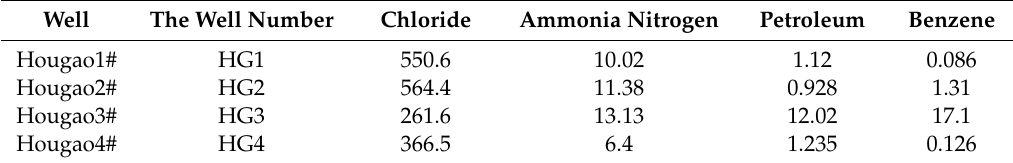
Table 2. Water quality monitoring data of Hougao’s four wells in May 2017 (mg / L). Well The Well Number